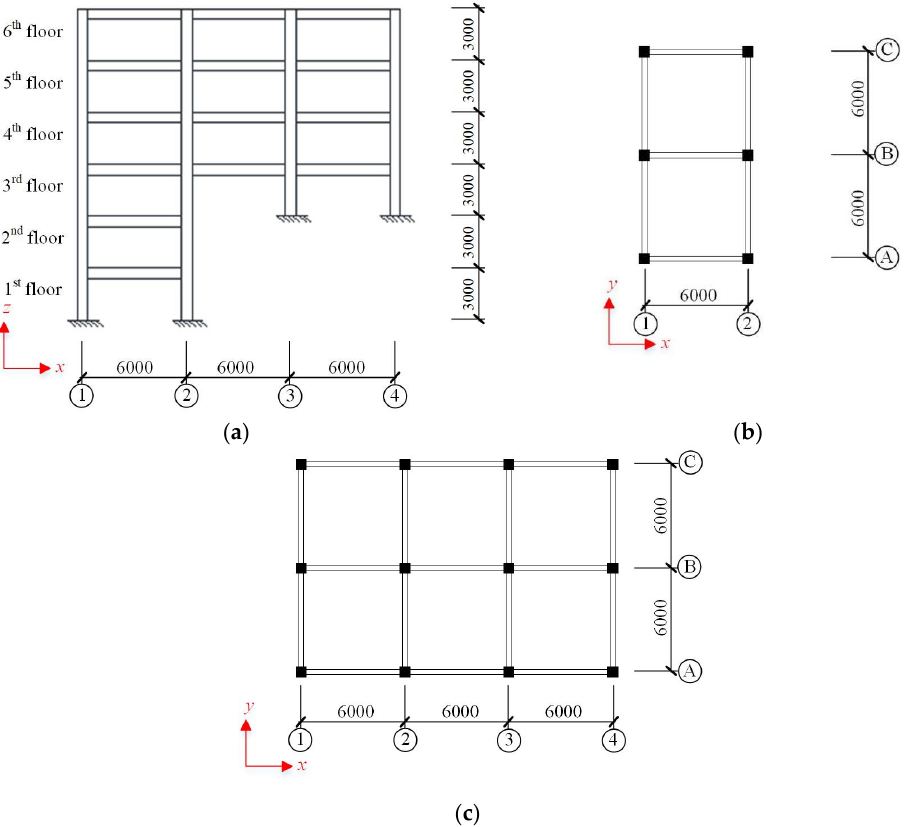
Figure 3. Layout of a typical MBS: ( a ) Elevation view; ( b ) Plan view from the 1st to 2nd floor; ( c ) Plan view from the 3rd to 6th floor.